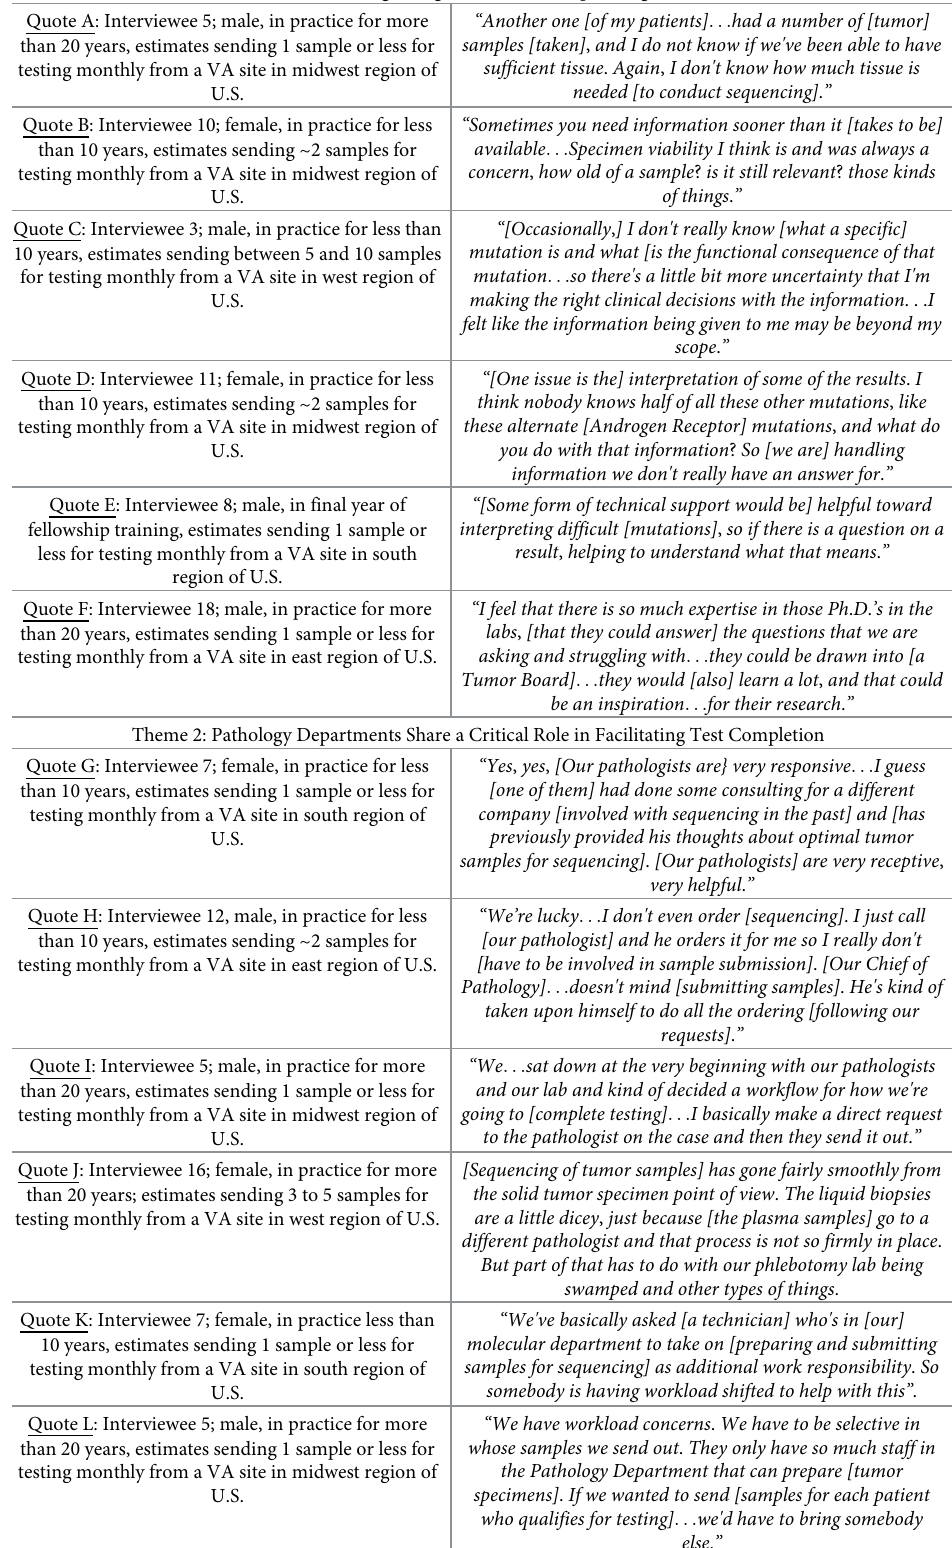
Table 2. Indicative quotations from interviewed